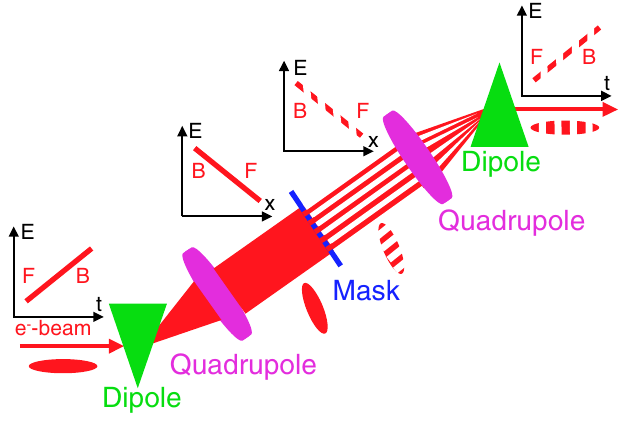
FIG. 3. (Color) Picture of the mask showing the frame support- ing the wires with diameter d ¼ 500 (cid:8) m and period D ¼ 1 : 27 mm . The steel wires are approximately horizontal in the picture and vertical in the